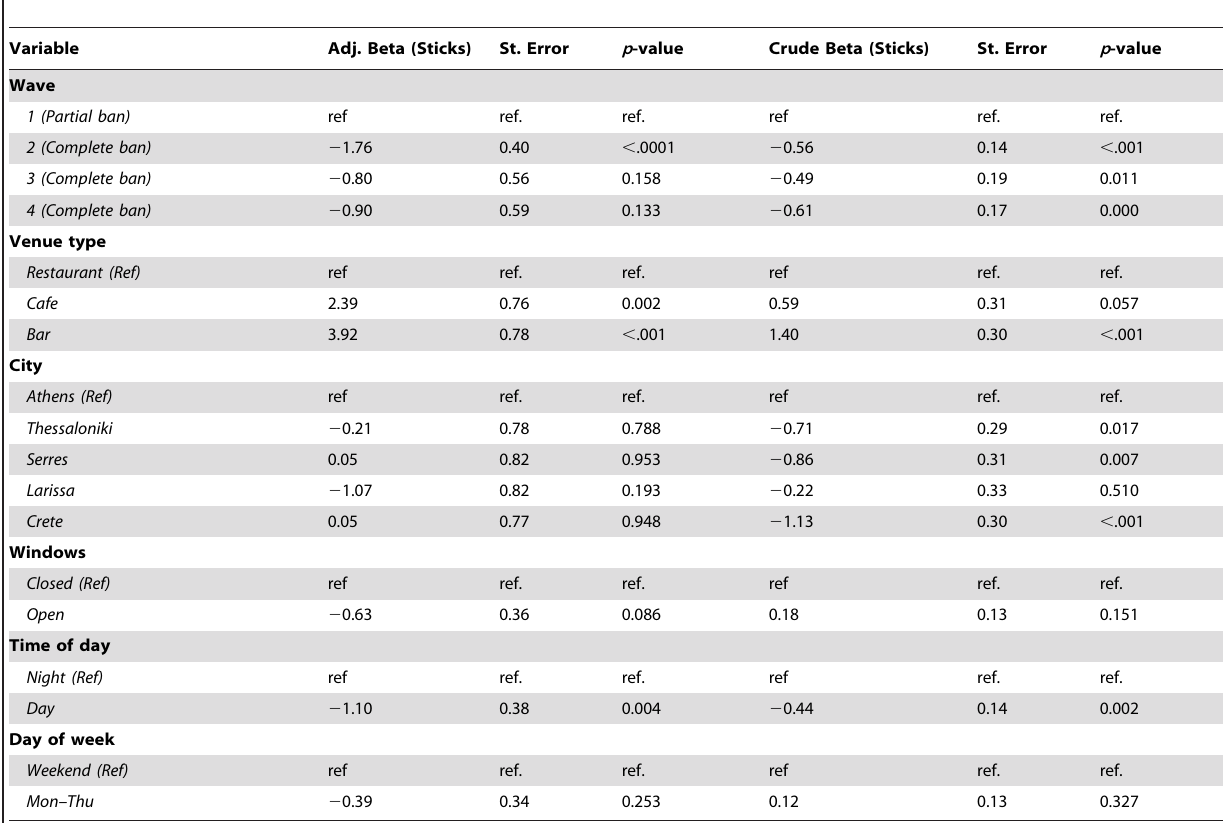
Table 4. Adjusted 1 and crude linear regression models for the relationship between venue and measurement characteristics and average number of cigarettes 2 within hospitality venues in Greece (N =445),